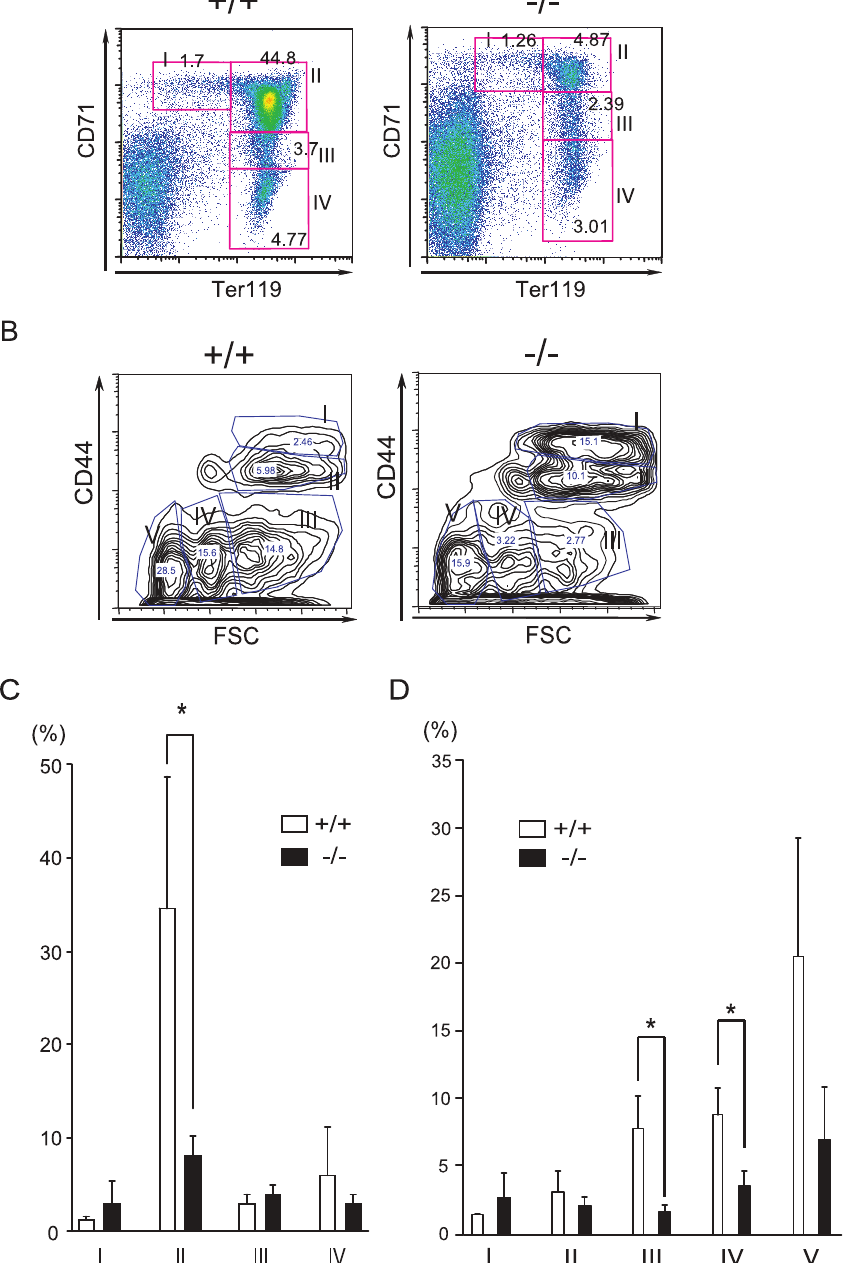
Figure 3. FACS analyses of erythroblasts at different stages of maturation in wild-type or CALM -deficient mice. (A) Representative flow cytometry histograms. In 3-week-old mice, erythroblasts at different maturation stages were identified by double staining with FITC-conjugated anti- TER119 and PE-conjugated anti-CD71 Abs. (B) Representative flow cytometry histograms. Erythroblasts at different maturation stages were identified by double staining with FITC-conjugated anti-TER119 and APC-conjugated anti-CD44 Abs. Plots of CD44 vs. forward scatter (FSC) for TRE119-positive cells are shown. (C) Quantification of regions I to IV of (A) (data represent means 6 SD; n=4). *, P , 0.05 vs. control. (D) Quantification of regions I to V of (B) (data represent means 6 SD; n=5). *, P , 0.05 vs.